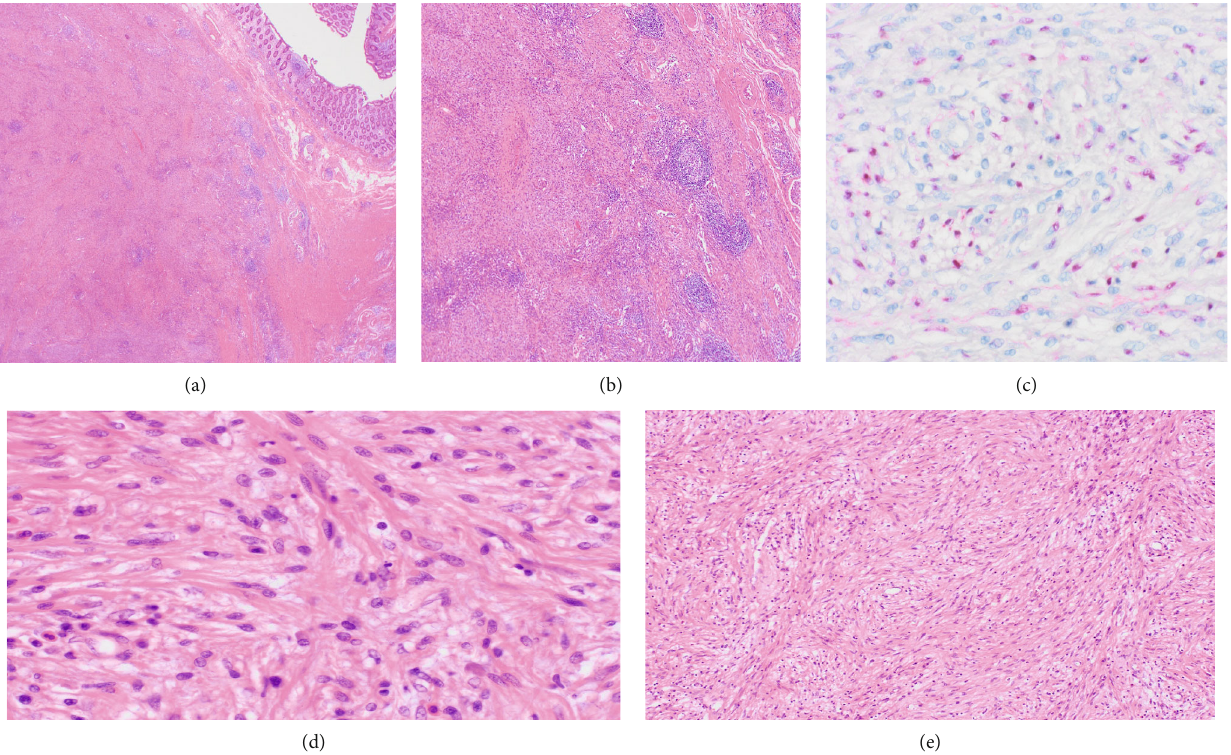
Figure 2: (a) Spindle cell lesion in appendix wall predominantly in muscularis propria. (b) Associated benign lymphoid reaction-typical of gastrointestinal GI schwannoma. (c) S100 positivity in the lesion. (d) Bundles of bland spindle cells (high power). (e) Bundles of bland spindle cells (low power).